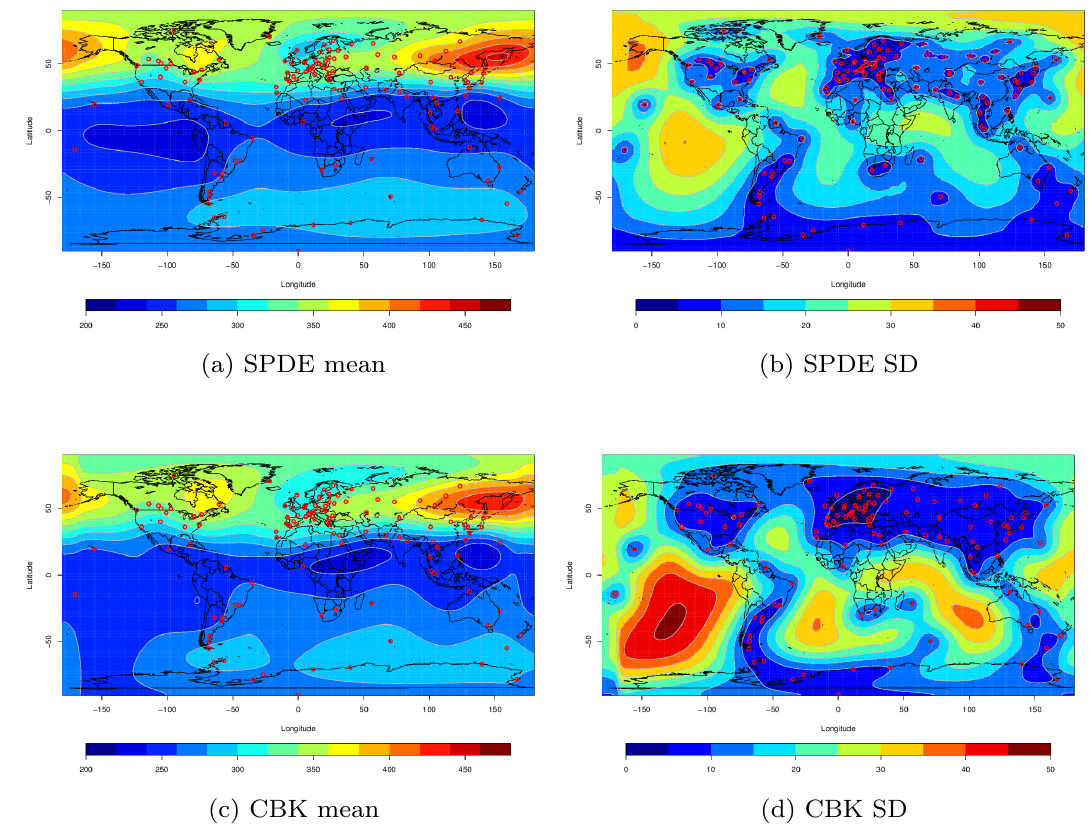
Figure 1. Surface predicted ozone (DU) mean and SD for SPDE (strategy D) and CBK (strategy B) from January 2000. The red points indicate the locations of stations.